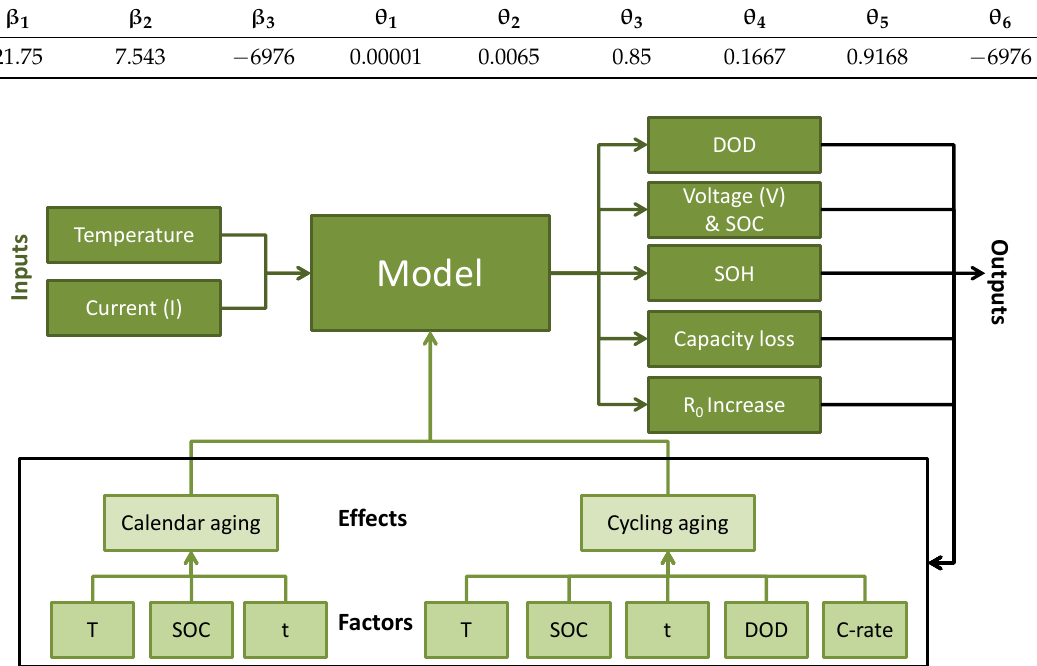
Figure 10. Schema of the aging model, identifying temperature and current as inputs, the factors affecting the calendar and cycling aging and the outputs of the model [24].